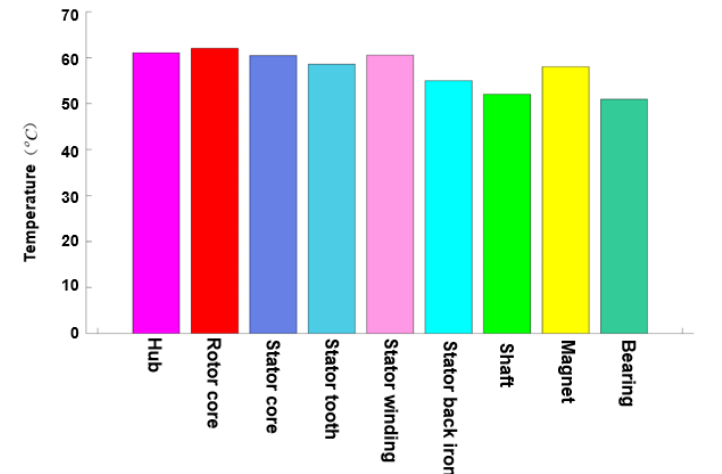
Figure 20. Peak temperature of IPMBLDC motor parts.